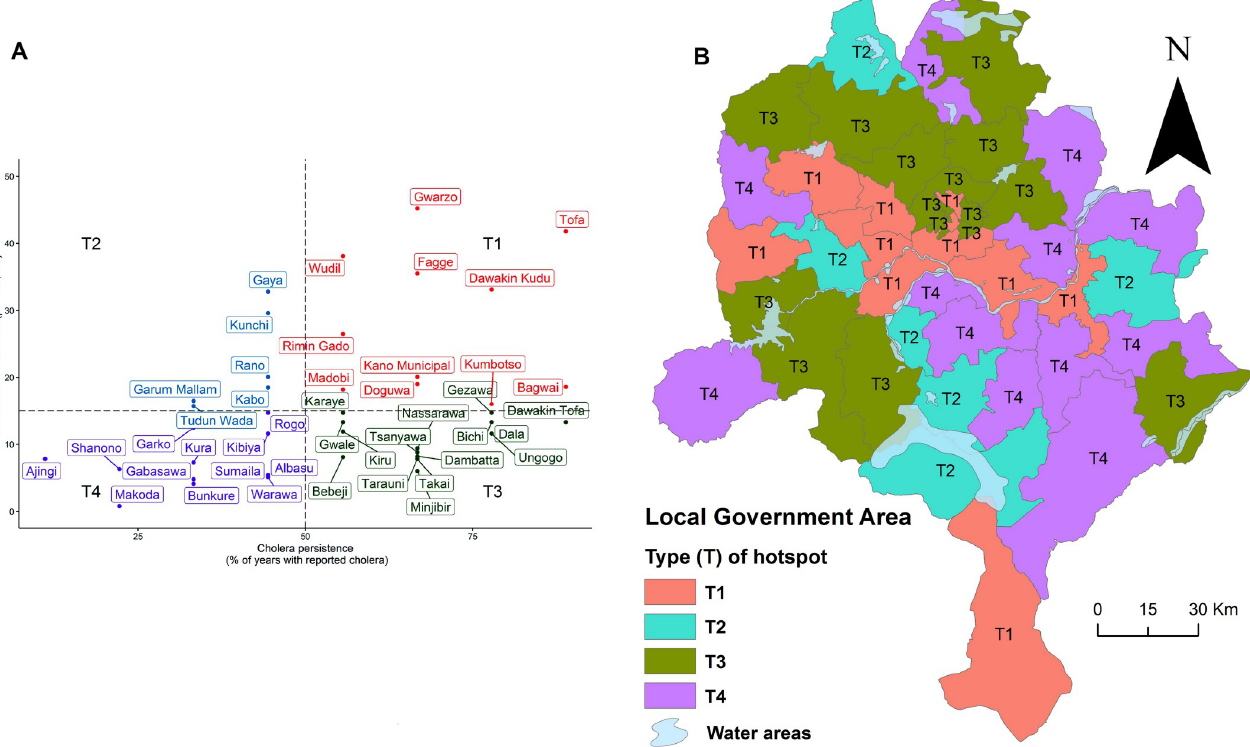
Fig 7. Cholera hotspot claissification chart (A) and map (B) for Kano State following GTFCC method using data from 2010–2019. (A) The persistence cut-off point is 50% and the mean annual incidence rate cut-off point is 15/100,000 population. T represents types of hotspot. T1 (high priority) reflects high mean annual incidence and high persistence of cholera; T2 (medium priority) shows hign mean annual incidence and low persistence of cholera; T3 (medium- low priority) indicates low mean annual Incidence and high persistence of cholera; and T4 (low priority) depicts low mean annual incidence and low persistence of cholera, respectively. The dots denote Local government Areas (LGAs) in the four types of hotspot quadrants. Compared with the statistical map in Fig 5, this GTFCC method misses seven LGAs in the T1 quadrant namely Kunchi, Kabo, Karaye, Gaya, Rano, Garum Mallam, and Tudun Wada, which, excepting Karaye, are in T2. However, this could be the result of the cut-off point. (B) Spatial map of the T (types of hotspots) in relation to permenent inland water areas/bodies.